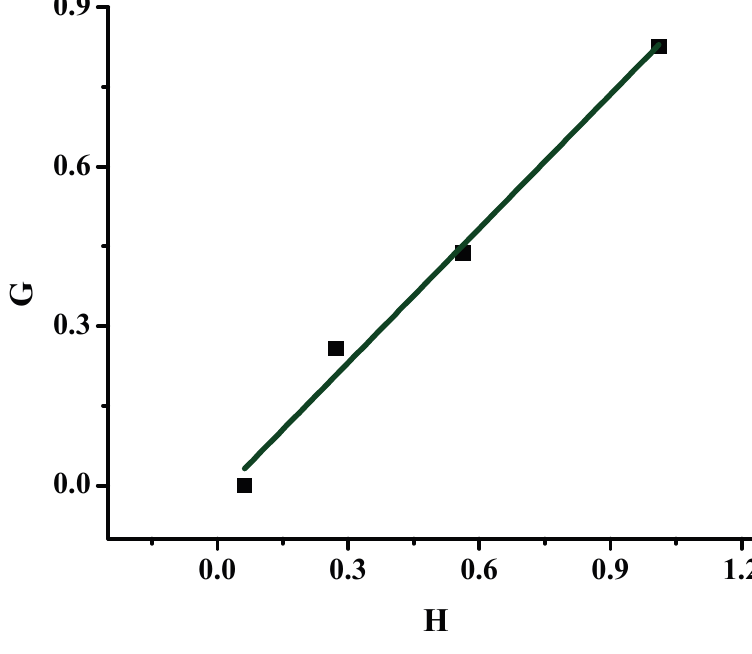
Figure 4. FR plot of the statistical copolymers prepared in the presence of PPh 3